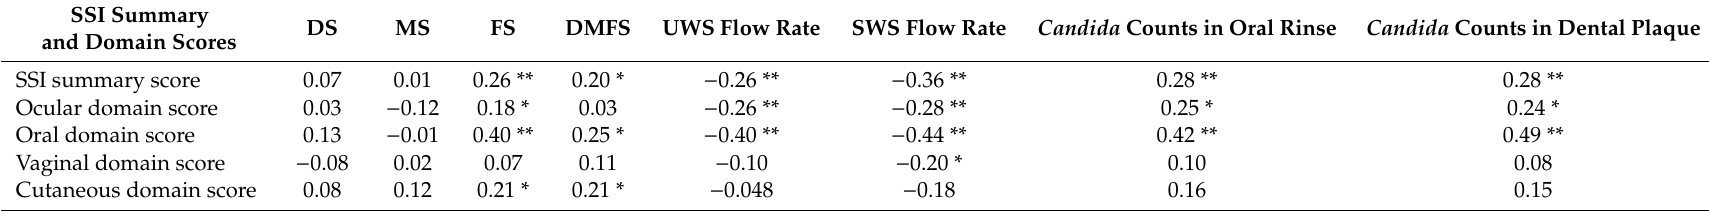
Table 3. Correlations (r s values) between SSI scores and dental conditions, salivary flow rates and Candida